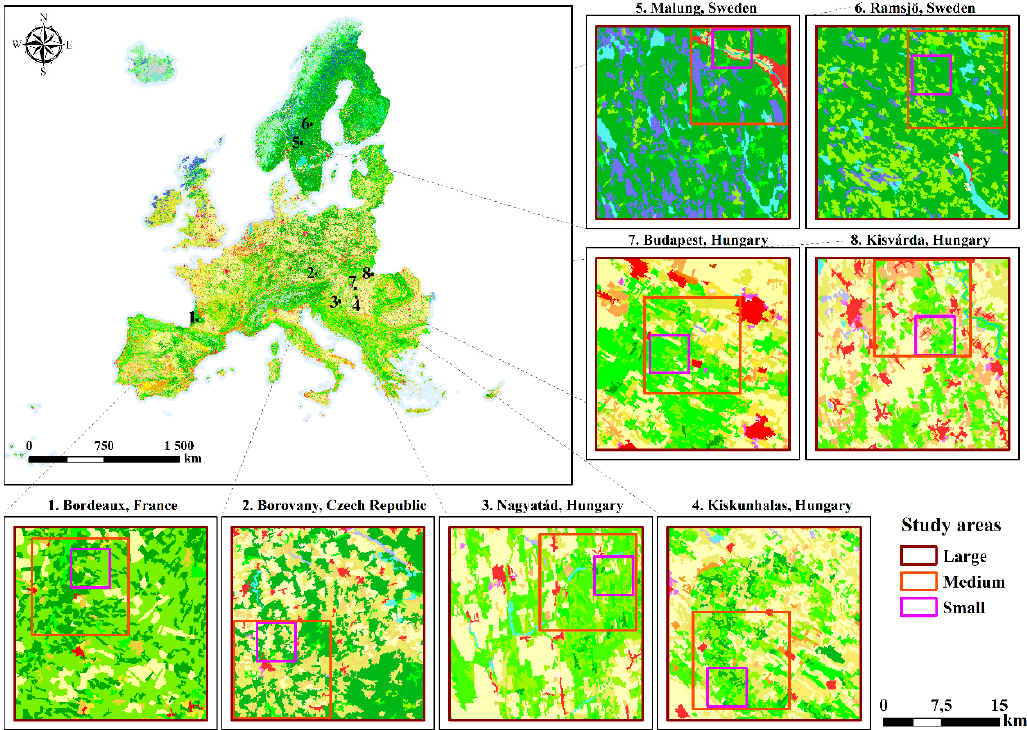
Figure 1. Location of the analyzed landscapes, in the context of the complete CLC2012 data with a maximum of 44 categories. The locations are assigned with numbers to locate the study areas in the Pan-European Corine Land Cover (CLC) dataset. The smaller maps depict each study area by zoom level (large, medium and small) in the 8 landscapes.